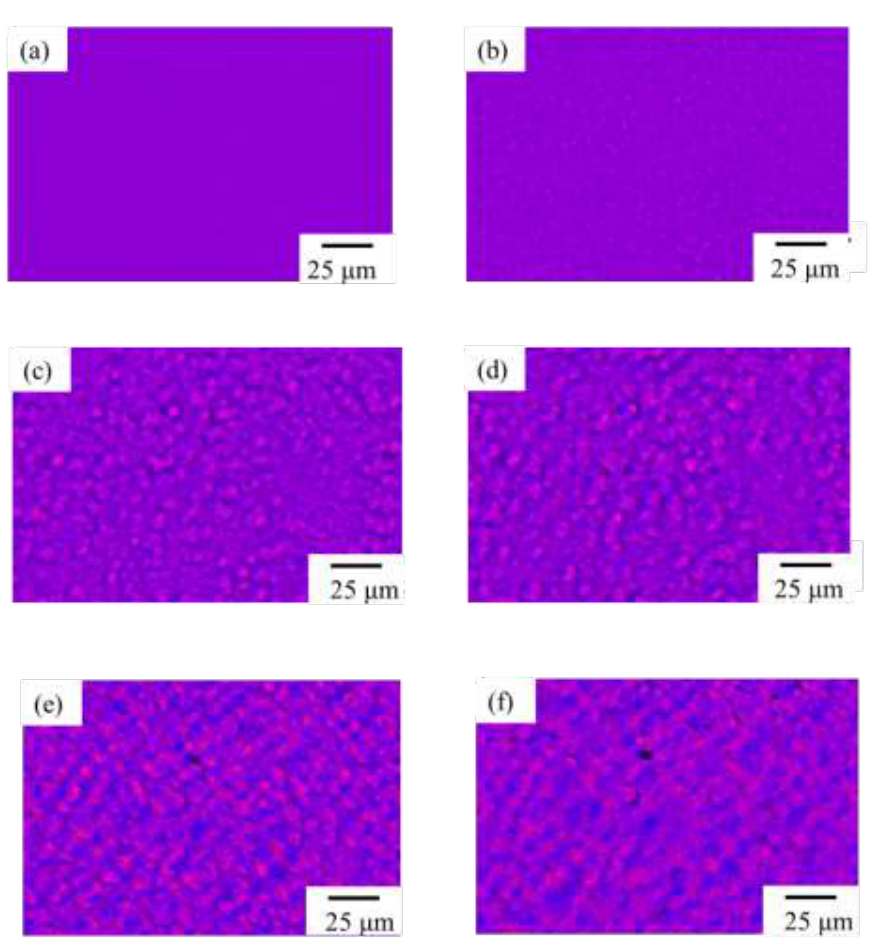
Figure 4. Morphological development of γ -spherulite of PVDF/TBAHS during isothermal crystallization at 165 °C: ( a ) 2 min, ( b ) 4 min, ( c ) 7 min, ( d ) 10 min, ( e ) 15 min, and ( f ) 20 min.